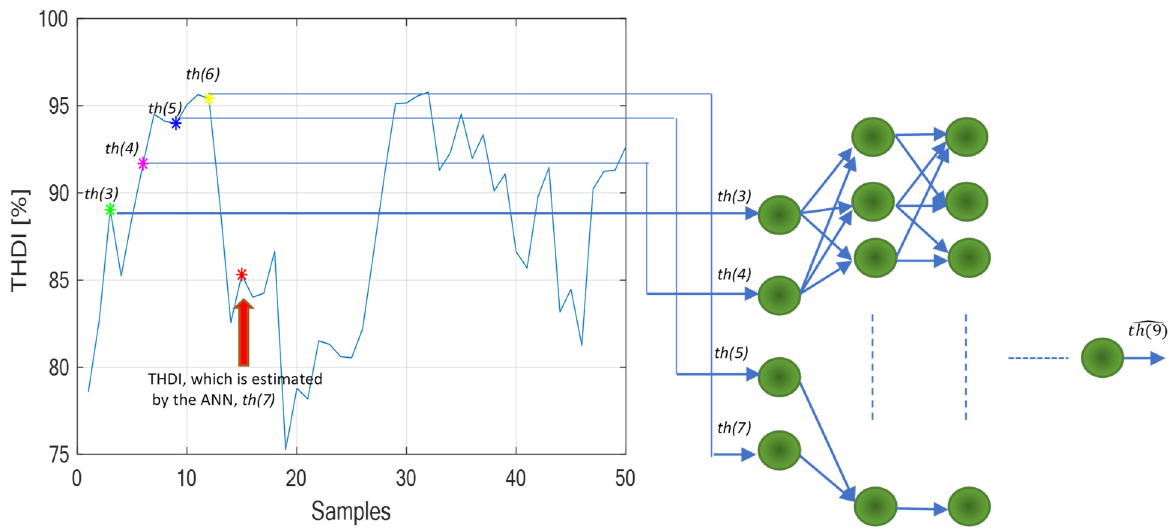
Figure 8. The development of the first layer of an ANN—GMDH for time series modeling and pre- diction.